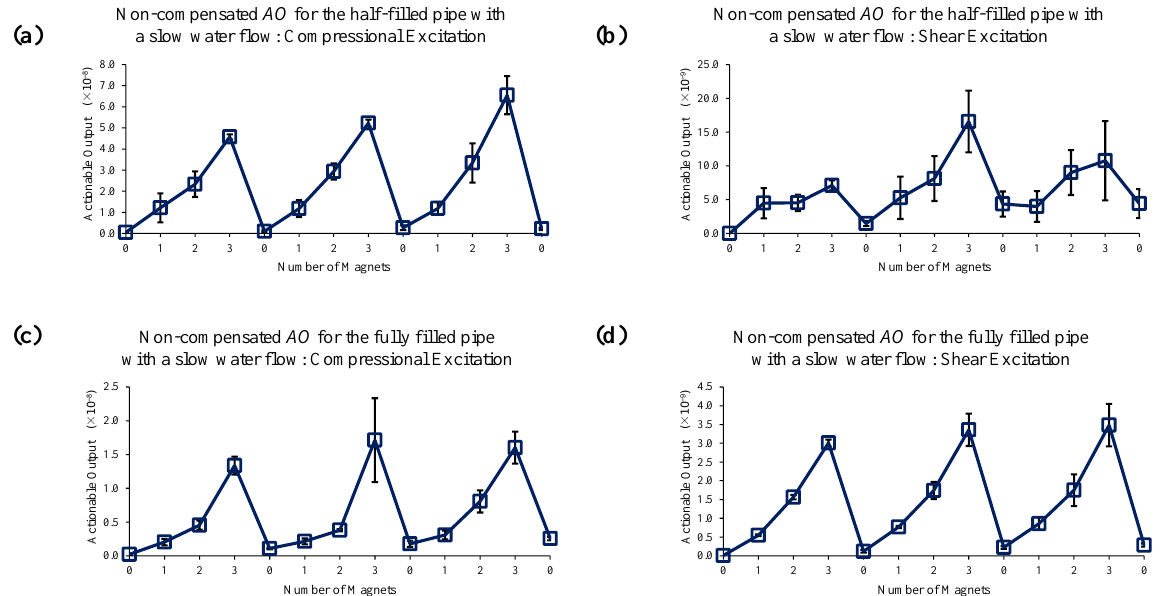
Figure 14. Changes in AO under slow water-flow conditions with the different number of magnet perturbations for the half-filled pipe with ( a ) compressional and ( b ) shear excitations; and the fully filled pipe with ( c ) compressional and ( d ) shear excitations. No EOC compensation method is applied.